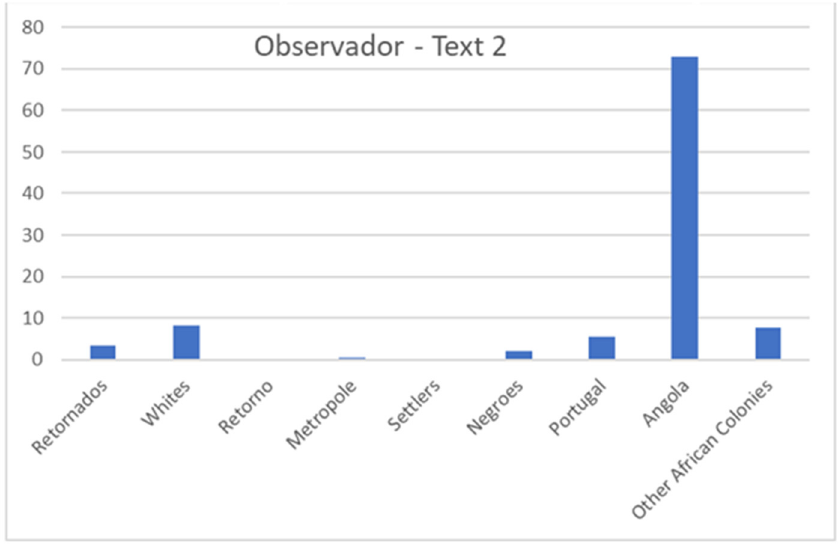
Figure 4. Most commonly used words in the newspaper text “Há 40 anos, o desespero dos retornados: Tirem-nos daqui!”. Source: Observador (2015) [20].